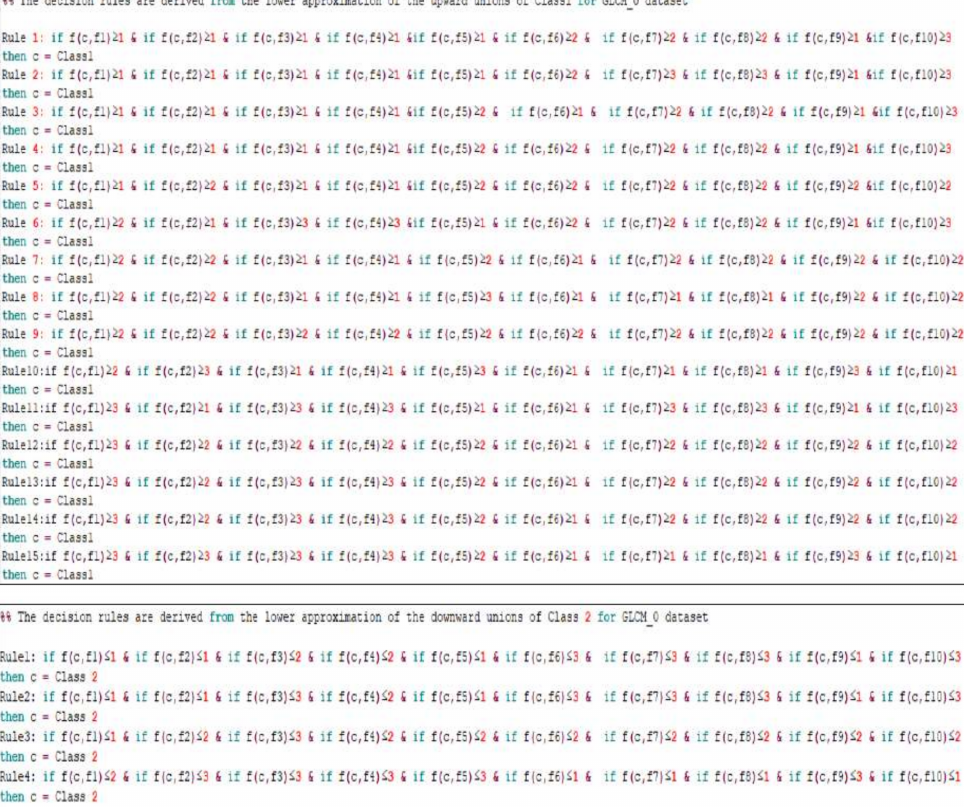
Figure A1. Derived rules using IDSSDRP